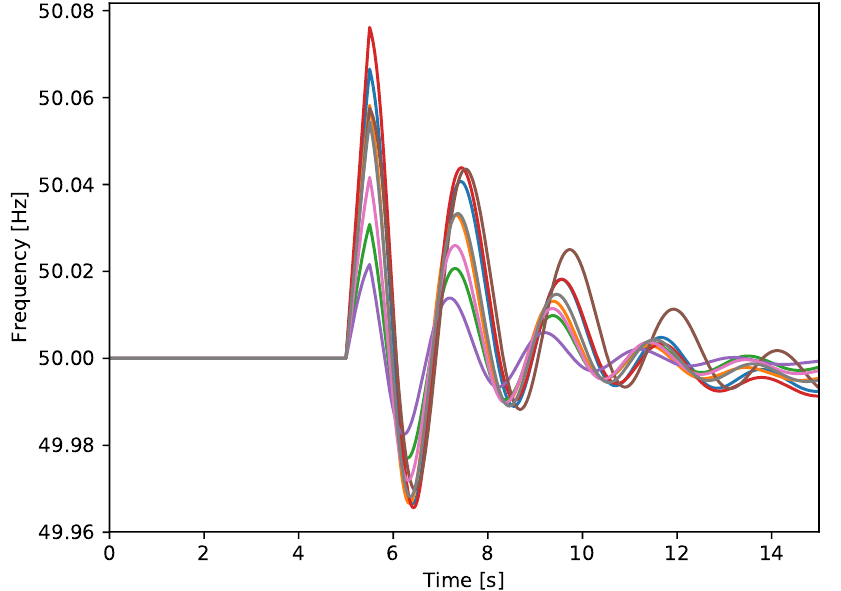
Figure 6. Frequency transient of generator G1 output for line L7to8A trip and reclosure events based on eight different operating points generated in test case